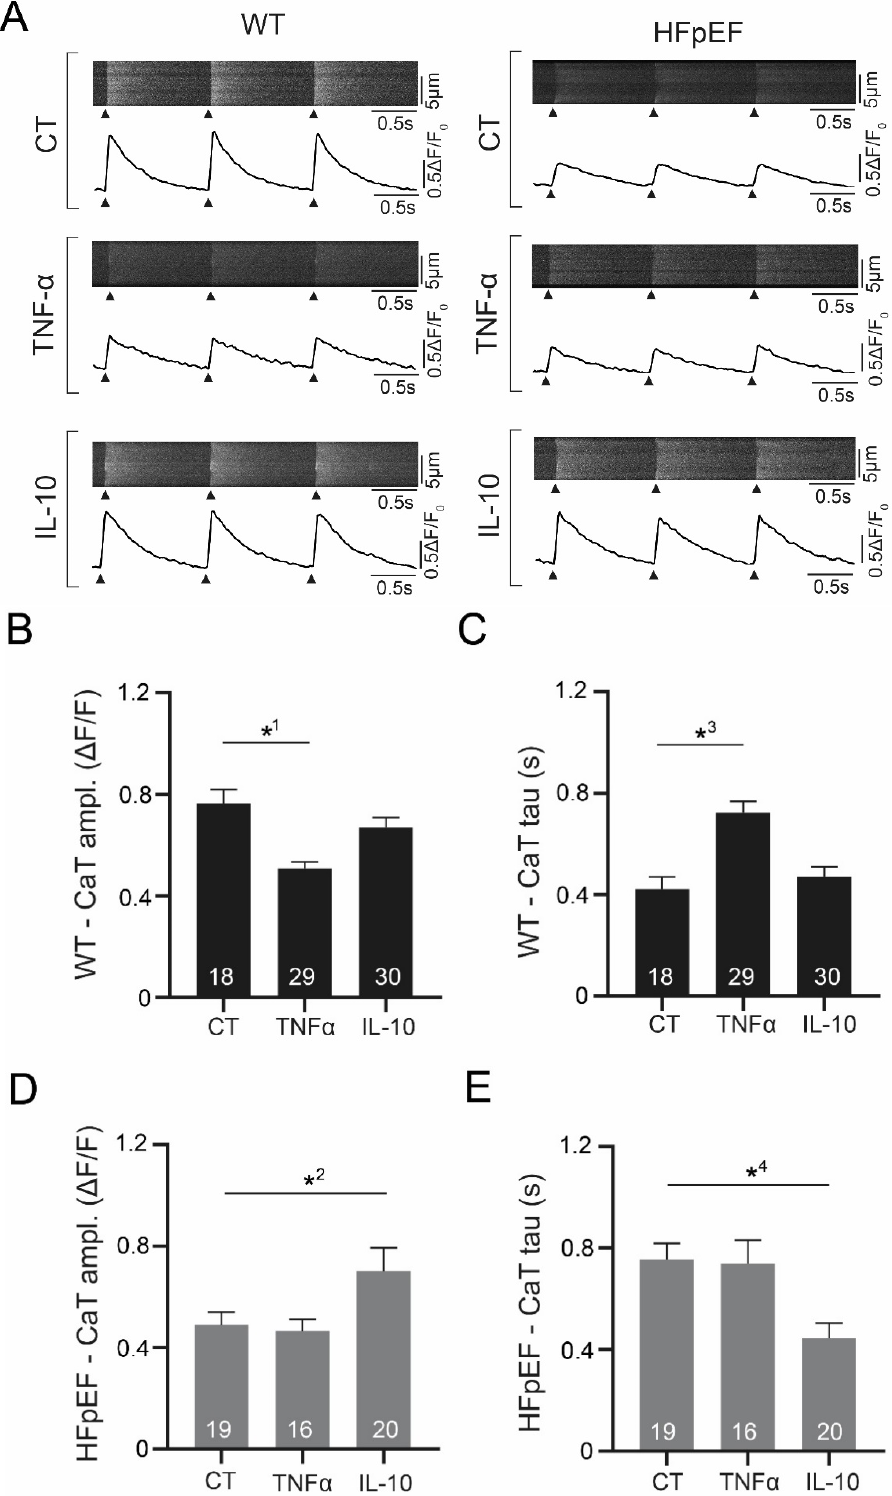
Figure 3. ( A ) Representative example of three consecutive CaT of left atrial cardiomyocytes after 1 h incubation in Tyrode solution (CT; upper), with additional TNF- α (center) or IL-10 (lower; 10 µ M, respectively) in WT (left) and HFpEF (right) at 1 Hz electric stimulation (black arrows indicate stimulation triggers). ( B ) Corresponding CaT amplitude and ( C ) tau of decay of WT. ( D ) Corresponding CaT amplitude and ( E ) tau of decay of HFpEF. Statistical analysis: One-way ANOVA, post-hoc Bonferroni. p -values: * 1 < 0.0001, * 2 < 0.0001, * 3 0.0175, * 4 0.0009. n -numbers indicate cells (from four animals per group).